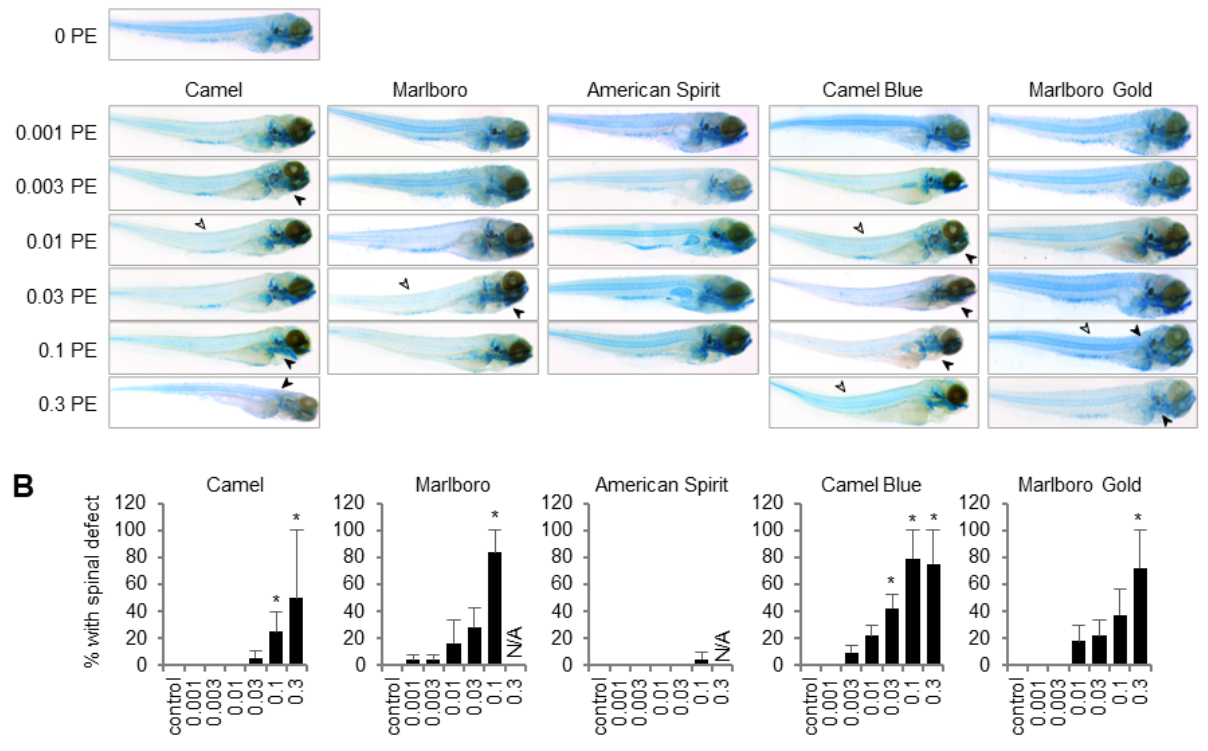
Figure 2. Tobacco products affected cartilage development in zebrafish. Embryos were placed in a tobacco smoke solution containing E3 embryo media at 5 hpf and collected, fixed, and stained with Alcian Blue at 6 dpf. ( A ) Representative images of Alcian Blue staining assessed with a light microscope. Note that larvae were oriented according to the location of the sac with respect to the body axis. Spine curvature is denoted with open arrowheads, twisted spines (in relation to the head) are denoted with closed arrowheads. ( B ) Defects in spinal development were assessed in the surviving embryos, n = 24. X-axis gives SS tobacco smoke concentrations in puff equivalents (PE). * p < 0.05, one-way ANOVA with a Dunnett’s post hoc test to correct for multiple comparisons. N/A, not assessed; PE, puff equivalent.